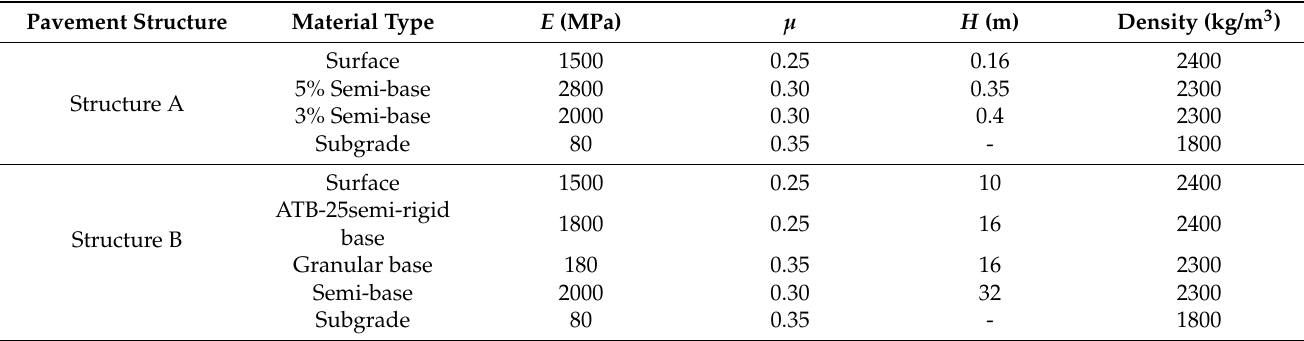
Table 3. The pavement structure and material parameters.